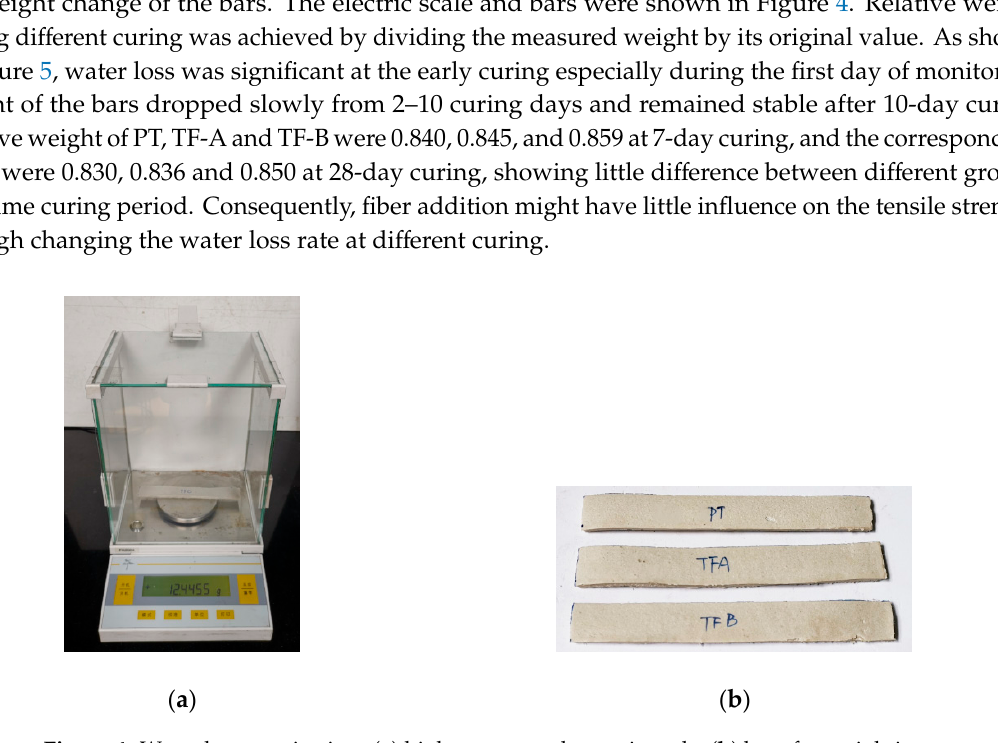
Figure 4. Water loss monitoring. ( a ) high-accuracy electronic scale, ( b ) bars for weighting.